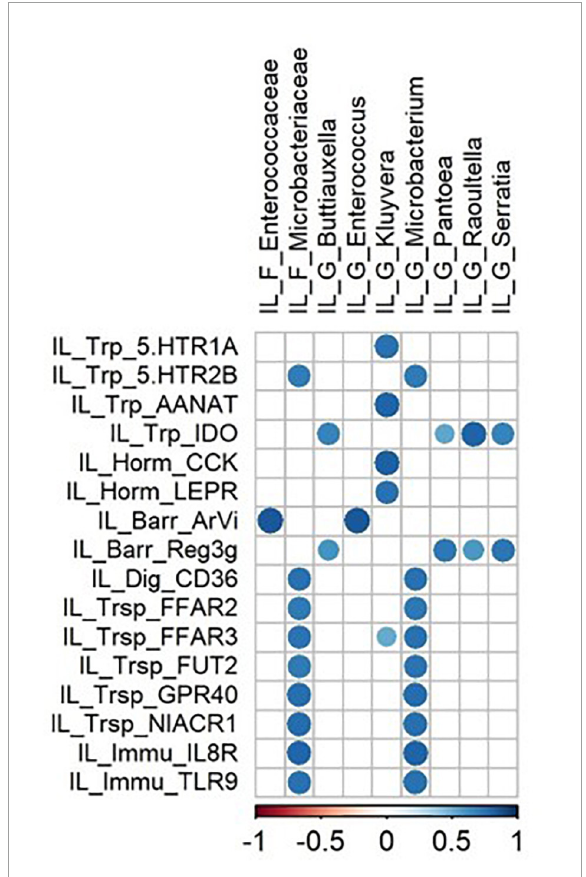
FIGURE3 Correlations matrix between ileal variables (genes, morphometry data) and ileal microbiota (| r | ≥ 0.7, P < 0.05). IL, ileum; F, family; P, phylum; G, genera; ArVi, villous area; Trp, tryptophan pathways; Horm, endocrine function; Barr, barrier function; Dig, digestion function, Trsp, transport-nutrient carrier; Immu, immune